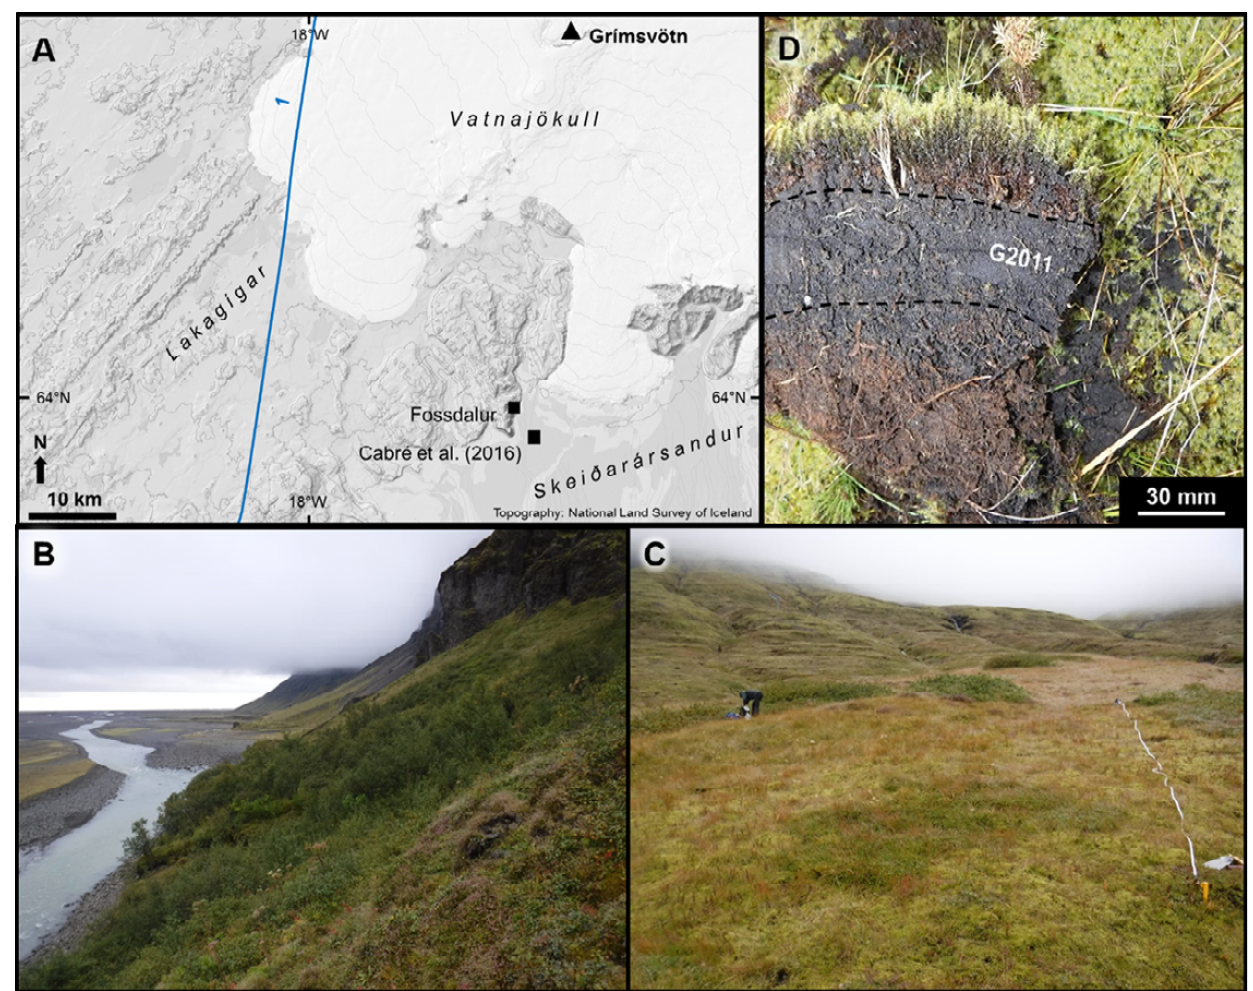
Figure 3: [A] Isopach map of the tephra deposit from the Grímsvötn eruption of 2011 , showing the study location at Fossdalur. The isoline (cm) is based on Thordarson and Höskuldsson [2020]. Topography provided by National Land Survey of Iceland [2012]. [B] The location of the birch woodland sampling grid at Fossdalur, looking south. [C] The location of the moss heath sampling grid at Fossdalur, looking west. [D] Sample section at Fossdalur (moss heath) showing tephra from Grímsvötn (2011) near the surface. Dashed lines show indicative contact between tephra and